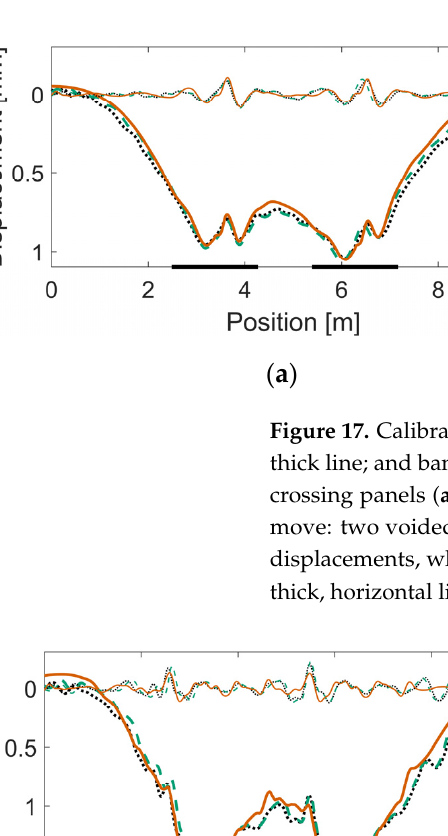
20 of 27 Table 6. Summary of calibrated track model parameters. Calibration Parameters Crossing Panel